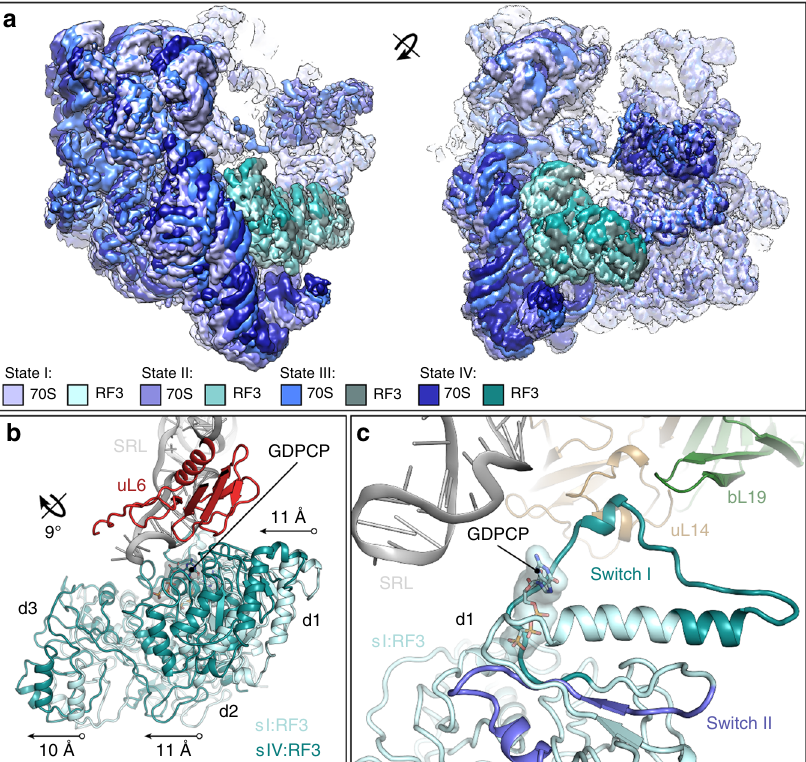
Fig. 4 Small subunit rotation leads to RF3 accommodation on the large subunit. a Two views of the cryo-EM maps of the 70S ribosome (different shades of blue) and RF3 (different shades of green) from states I – IV, illustrating the coupled rotation of the SSU and RF3 relative to the LSU. b Comparison of the binding site of RF3 in state I (pale cyan, sI:RF3) and state IV (teal, sIV:RF3) relative to ribosomal protein uL6 (red) and sarcin-ricin loop (SRL, grey). The distance shifted of each domain (d1 – d3) of RF3 between states I and IV is indicated. c View showing the G domain of RF3 in state I (pale cyan, sI:RF3) with switch I (teal), switch II (slate), GDPCP and proximity to SRL (grey), ribosomal proteins uL14 (tan) and bL19